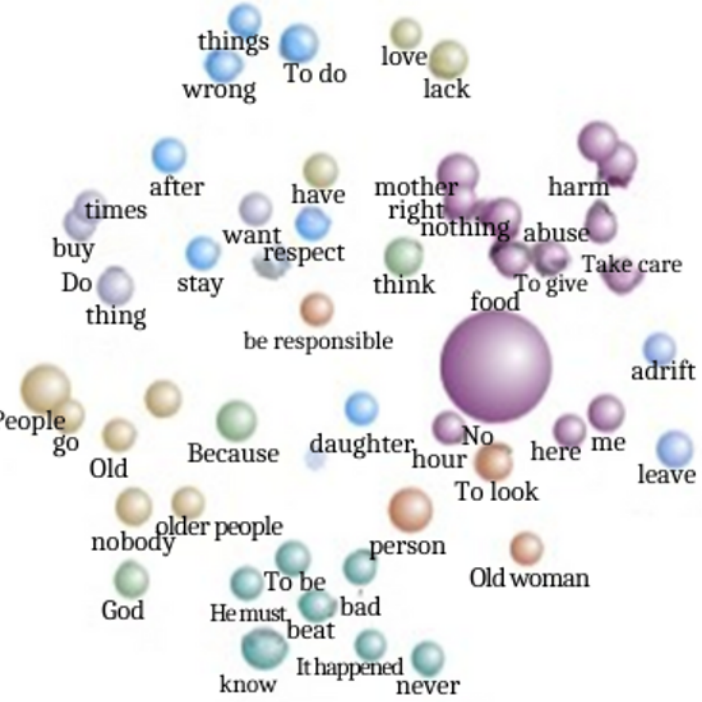
Figure 3. Two-dimensional (2D) cluster diagram of the social presentations of violence among older people with functional dependence.